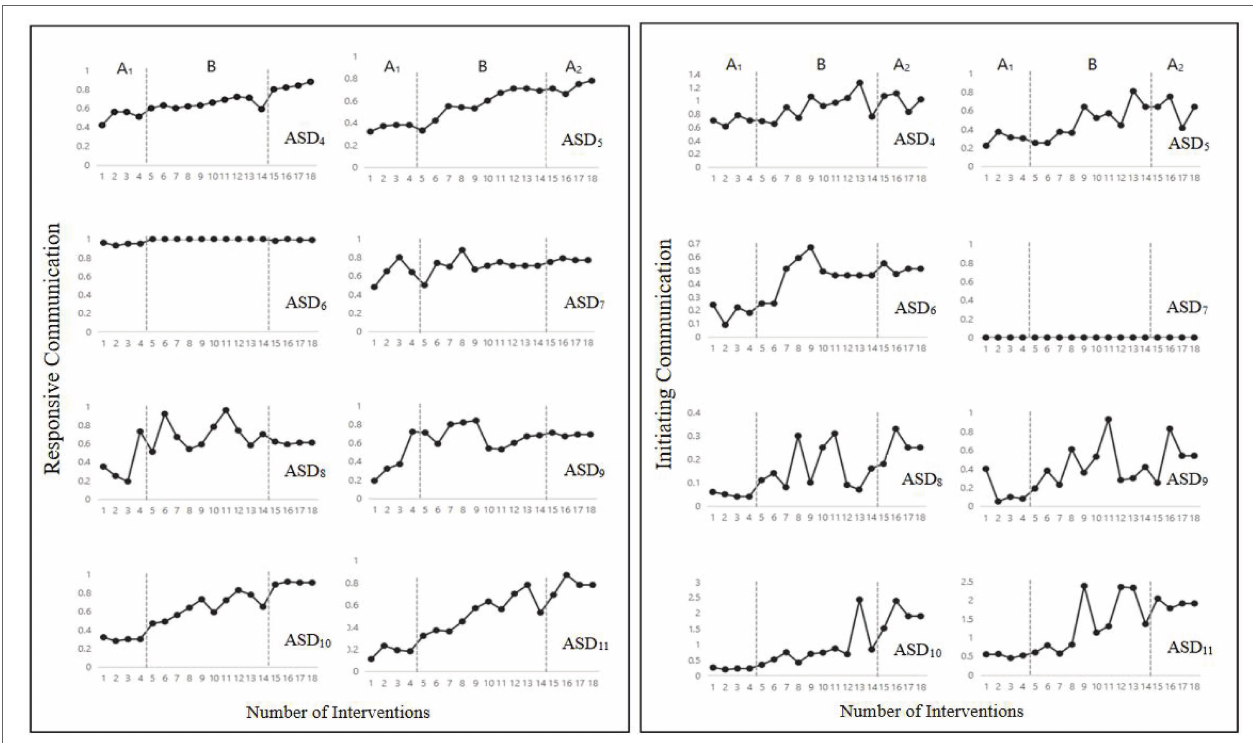
FIGURE 3 | The change in subject-researcher responsive (left side) and initiating (right side) communication in the three intervention stages (Study